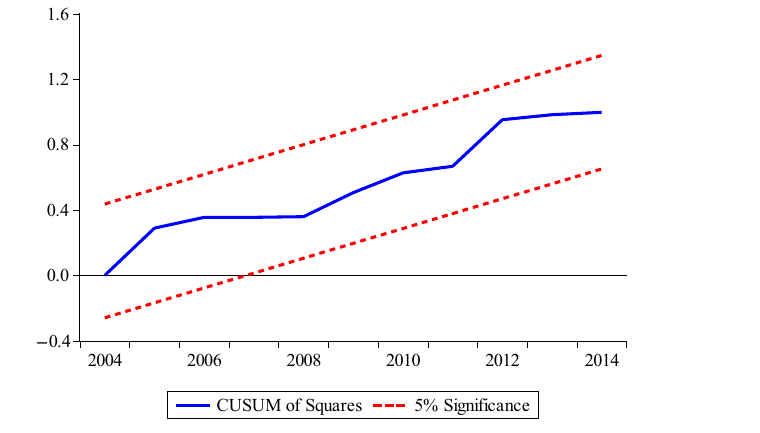
Figure A3. Plot of CUSUM of squares test